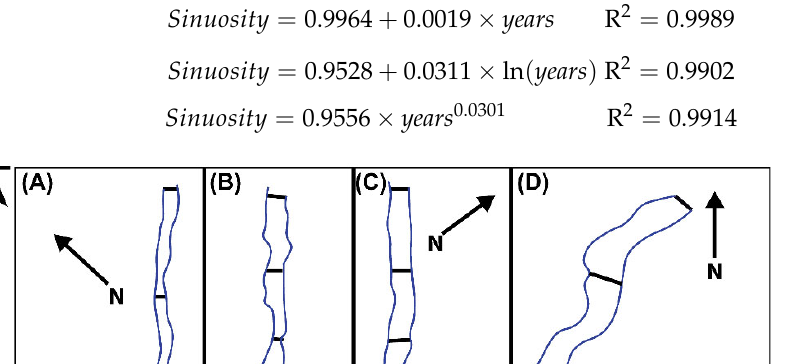
Figure 4. Sinuosity of the modified streams (1900N, Frog Creek, and Bray Creek) versus time since channelization. Crooked Creek sinuosity values are modeled using a linear (black dashed line), a logarithmic (gray dashed), and a power (black dash–dot–dot line) relationship. Note the x ‐ axis has a break between 380 and 10,000 years. Due to the limited number of streams in this study, all three functions represent a good fit. While the linear equation, Equation (3), possessed the best R 2 value, the relationship is unrealistic given that the sinuosity will reach an asymtope and not continually increase. The logarthhmic Equation (4) and the power Equation (5) equations